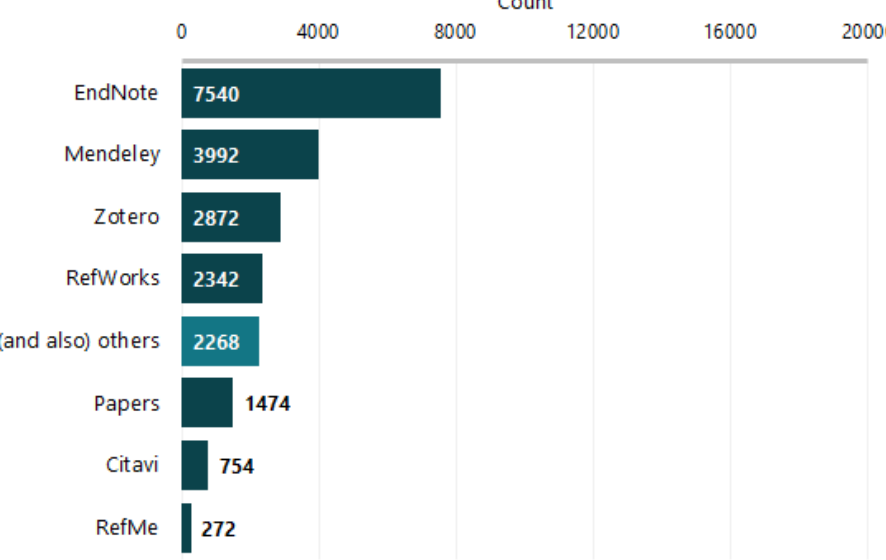
Figure 7: Fragment from the survey results demonstrating the tools for Reference management (source: https://101innovations.wordpress.com/survey-results/research-activities/reference-management/).